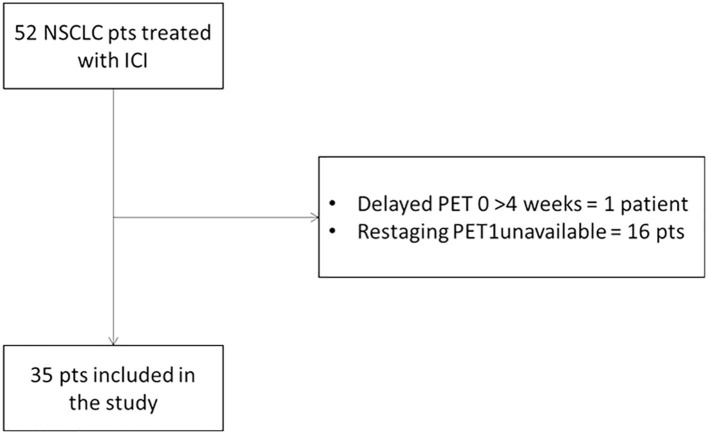
Flowchart of patient accrual.